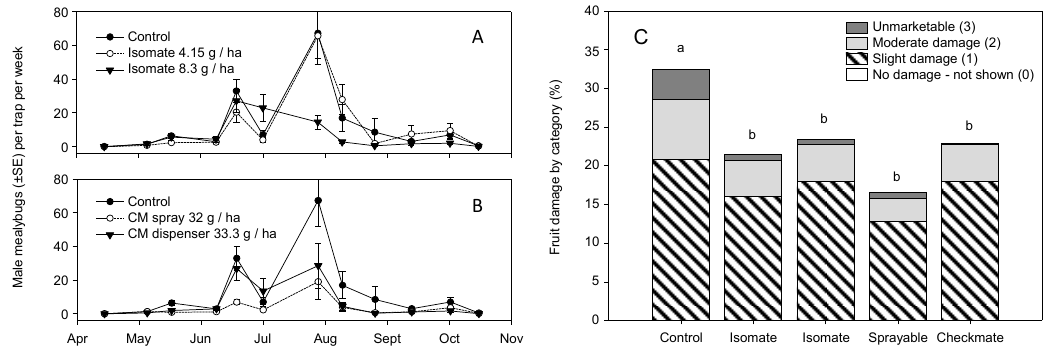
Figure 3. 2004 field studies of season-long adult male Pl. ficus (mean ± SEM) captures in pheromone-baited traps in plots with ( A ) Isomate dispensers (Scentry Inc.) hung at rates of 4.15 and 8.3 g a.i./ha; ( B ) CheckMate Flowable applied four times for a rate of 33.3 h a.i./ha and CheckMate dispensers hung at 19.8 g a.i./ha; ( C ) the categorical ranking of mealybug damage to fruit clusters at harvest time across all treatments (different letters above each bar represent significant differences, pairwise comparisons using an experiment-wide error rate at p < 0.005).